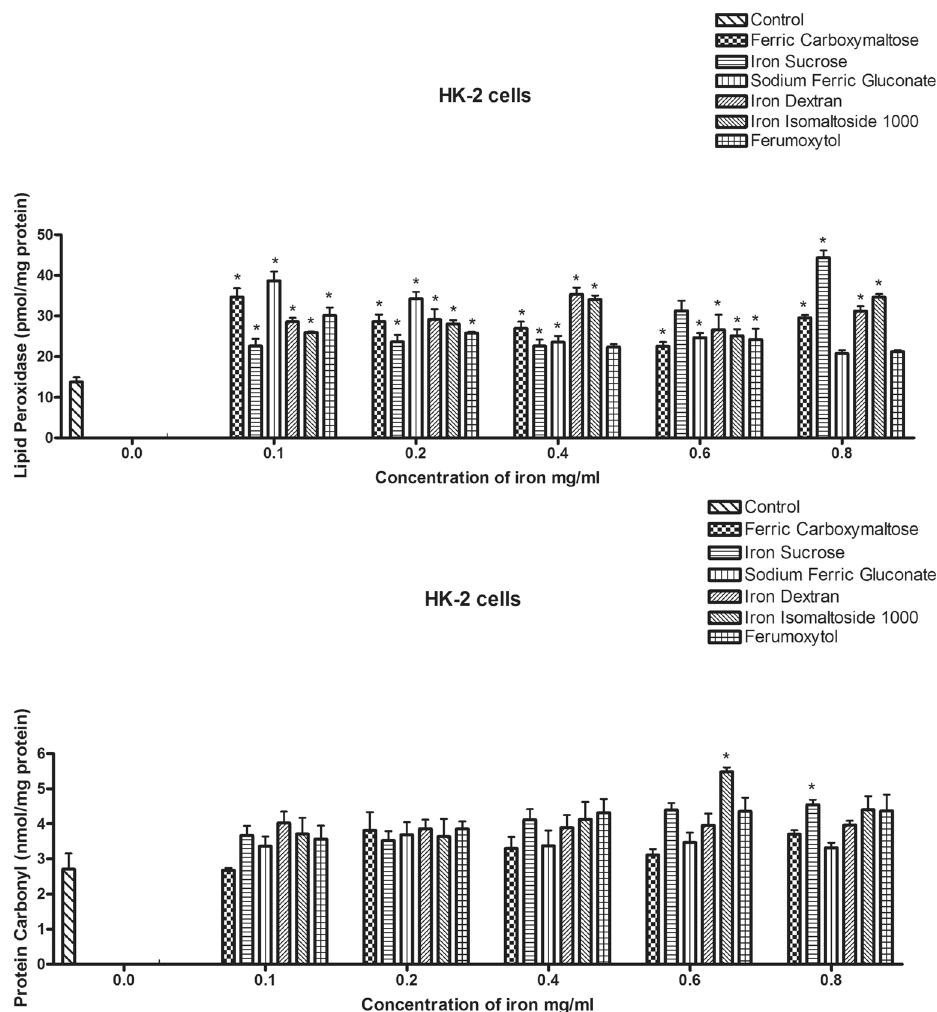
Fig 2. Effects of the iron compounds on markers of oxidative stress in HK-2 cells. HK-2 cells were seeded in T-75 culture flask (5 x 10 6 cells/flask). After 48 h of incubation, the medium was removed and replaced with Keratinocyte-serum free medium. The cells were exposed to the different iron compounds in doses ranging from 0.1 to 0.8 mg/ml for 24 hours. After 24 hours, cells were harvested and lysed for lipid peroxidation analysis (top figure, A) or assayed for oxidative modification to the proteins using the carbonyl assay (bottom figure, B). Data represents the mean ± SEM from three independent experiments and are compared to the control for statistical significance using 2- way ANOVA and post-hoc testing. * p < 0.05.